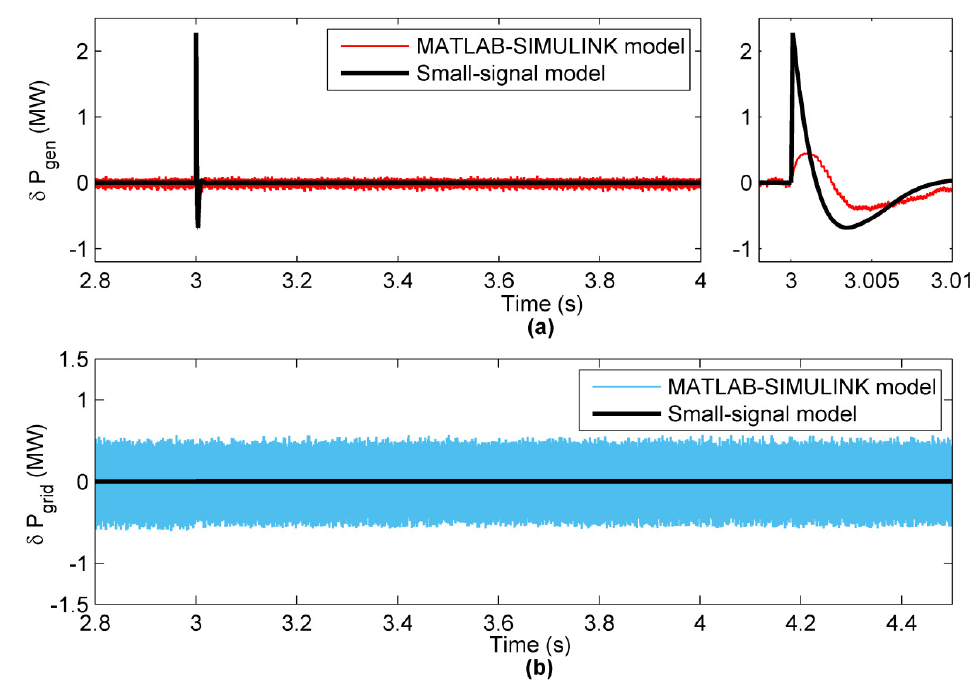
Figure 17. ( a ) The speed of the generator; and ( b ) the d-axis current of GSC ( δ i df ) in 30 V dc-link voltage variation.